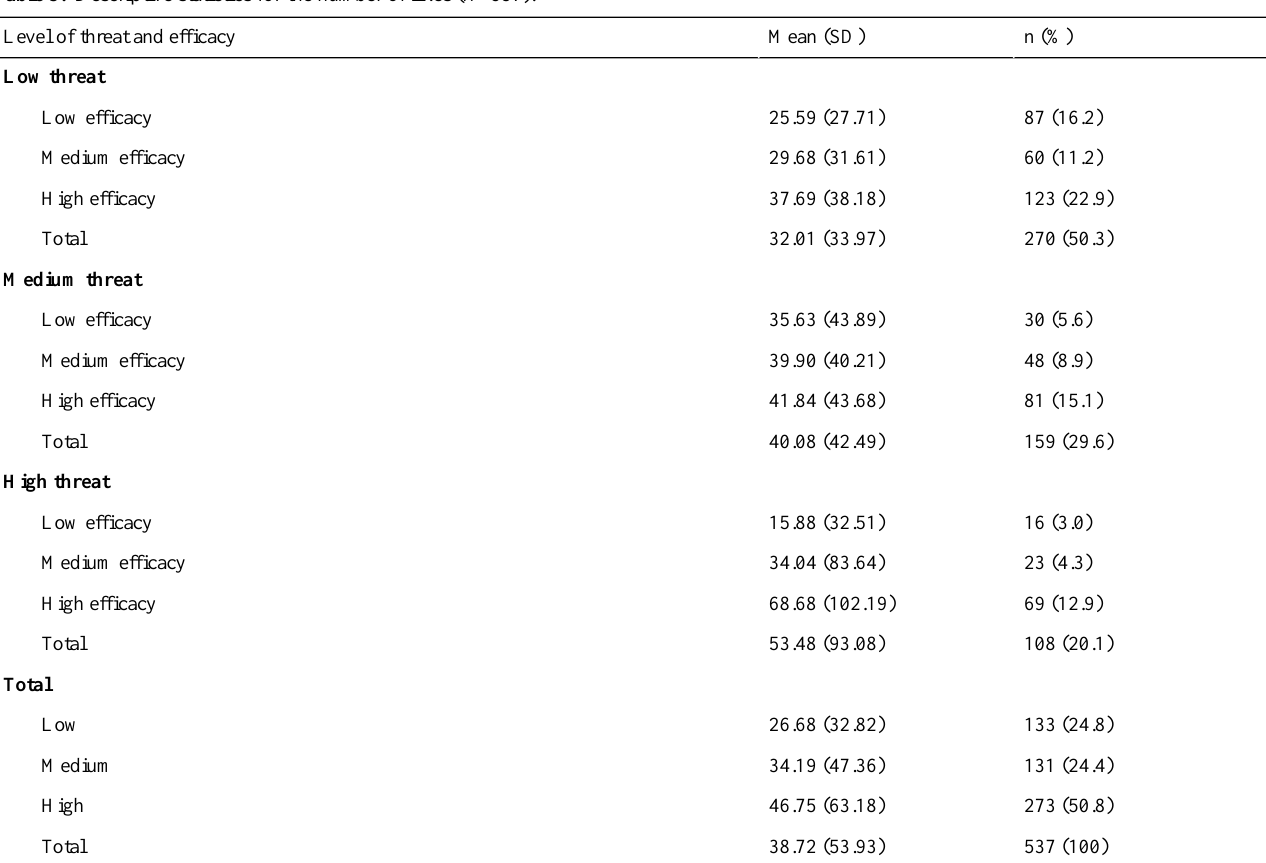
Table 3. Descriptive statistics for the number of likes